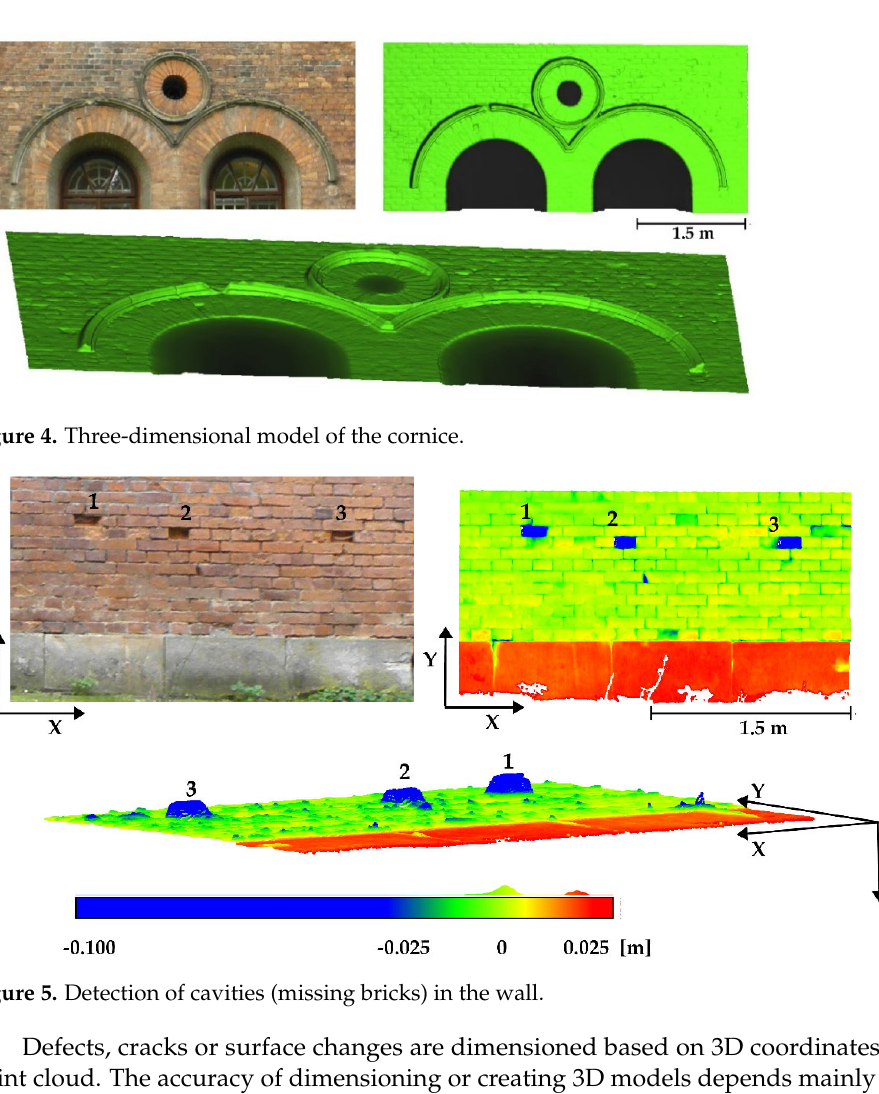
Figure 6. Dimensioning of cavity no. 2. Defects, cracks or surface changes are dimensioned based on 3D coordinates of the point cloud. The accuracy of dimensioning or creating 3D models depends mainly on the error of determining the coordinates ( x,y,z ) of points and the density of the point cloud. Point measurement error depends on TLS technical specifications, such as precision of distance measurement, vertical angle accuracy and horizontal angle accuracy, laser spot size and laser beam divergence (see Appendix B). Other factors such as weather conditions of the measurement, the type of surface scanning (colour, roughness, saturation) or the accuracy of point clouds registration in the one coordinate system also affect the accuracy of the final 3D models. In general, it can be assumed that the accuracy of dimensioning or building 3D models is a few millimetres. You can find many studies that present analysis of the accuracy of terrestrial laser scanning measurements [49–51]. Detection of other types of points of interest in the wall are also possible. In Figure 7, an exemplary detection of biological corrosion of the wall is presented. In this case, the